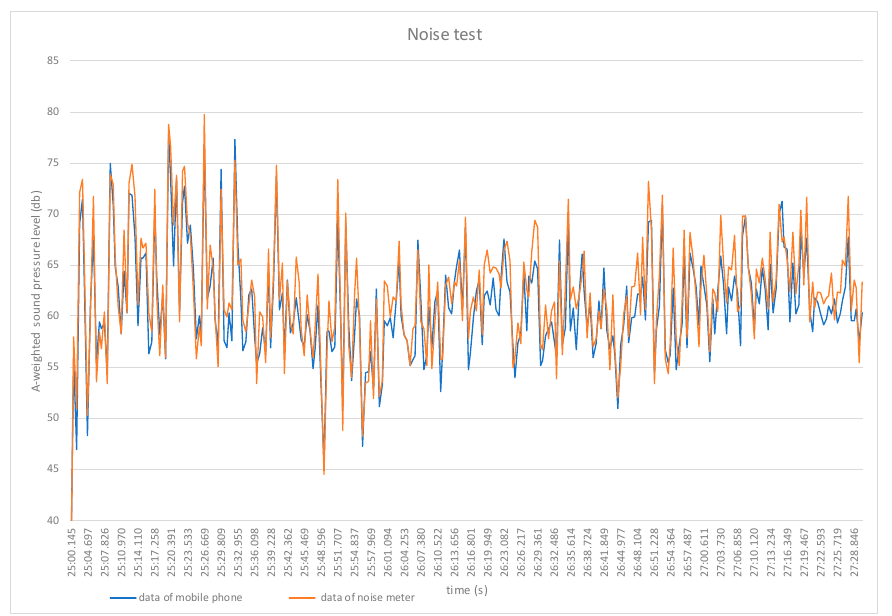
Figure 4. Comparison of noise data.